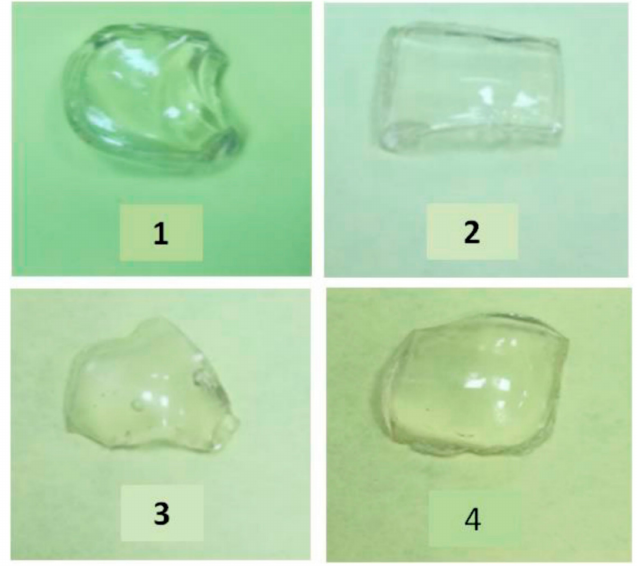
Figure 8. Photographs of wet PHEMMAC specimens containing: ( 1 ) 13.26 wt %; ( 2 ) 22.18 wt %; ( 3 ) 33.21 wt %; ( 4 ) and 63.32 mol %